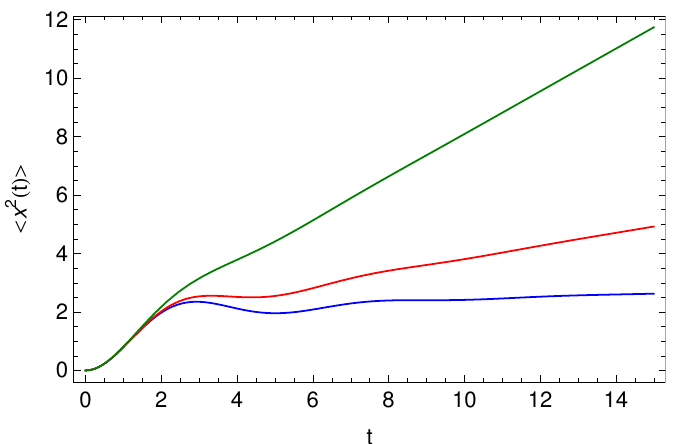
Figure 2. Graphical representation of the MSD (40), for k B T = 1, γ µ , ρ , δ = 1, τ = 1, ρ = 1/2, µ = 1/2, δ = 3/4, and b = 0 (blue line), b = 0.1 (red line) and b = 0.5 (green